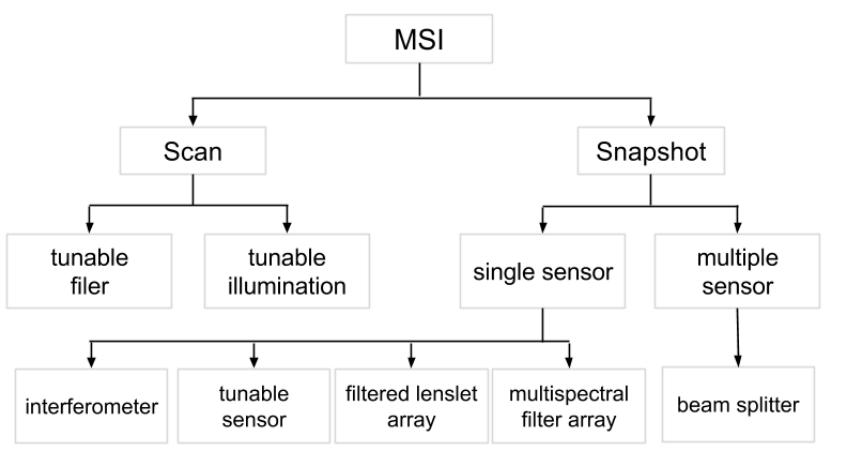
Figure 2. Classification tree of the main methods for multispectral